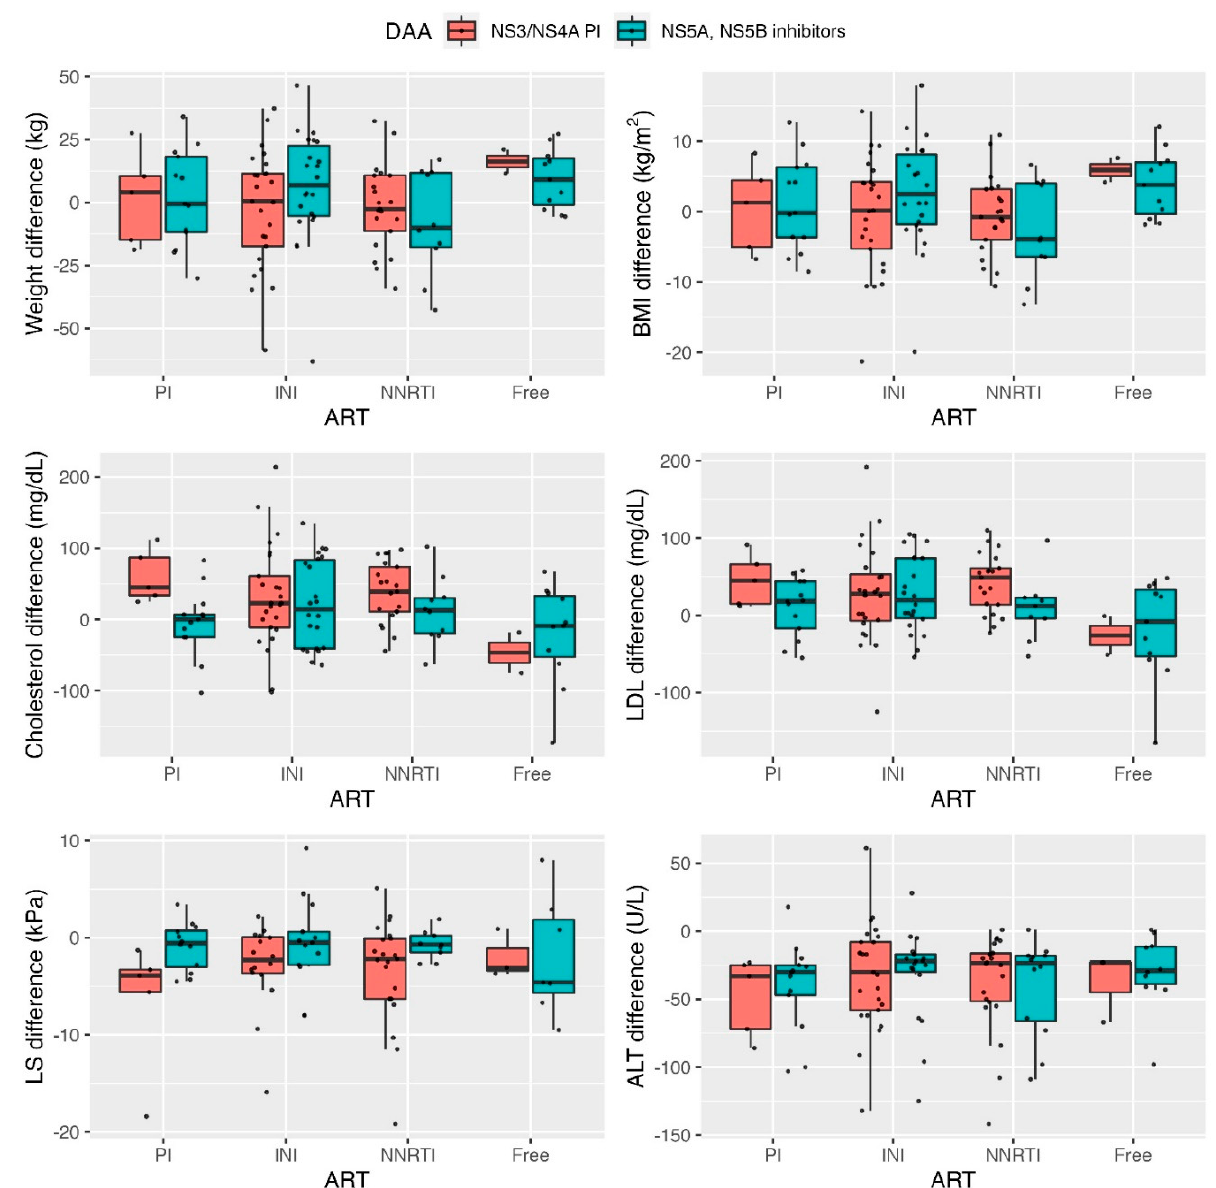
Figure 3. Differences (baseline vs. SVR12) post DAA therapy of the variables of interest in the types of treatments (ART and DAA). DAA, direct-acting antiviral; NS3/NS4 PI, non-structural protein 3/non-structural protein 4A protease inhibitors; NS5A, NS5B; non-structural protein 5A, non-structural protein 5B inhibitors; ART, antiretroviral treatment; PI, protease inhibitor; INI, integrase inhibitor; NNRTI, non-nucleoside reverse transcriptase inhibitor; Free, nucleoside analogue-free therapy. Rank and pseudo-rank hypothesis tests: Weight difference (kg) p = 0.3036; BMI difference (kg/m 2 ) p = 0.3988; Cholesterol difference (mg/dL) p = 0.0050; LDL difference (mg/dL) p = 0.1180; LS difference (kPa) p = 0.4118; ALT difference (U/L) p =